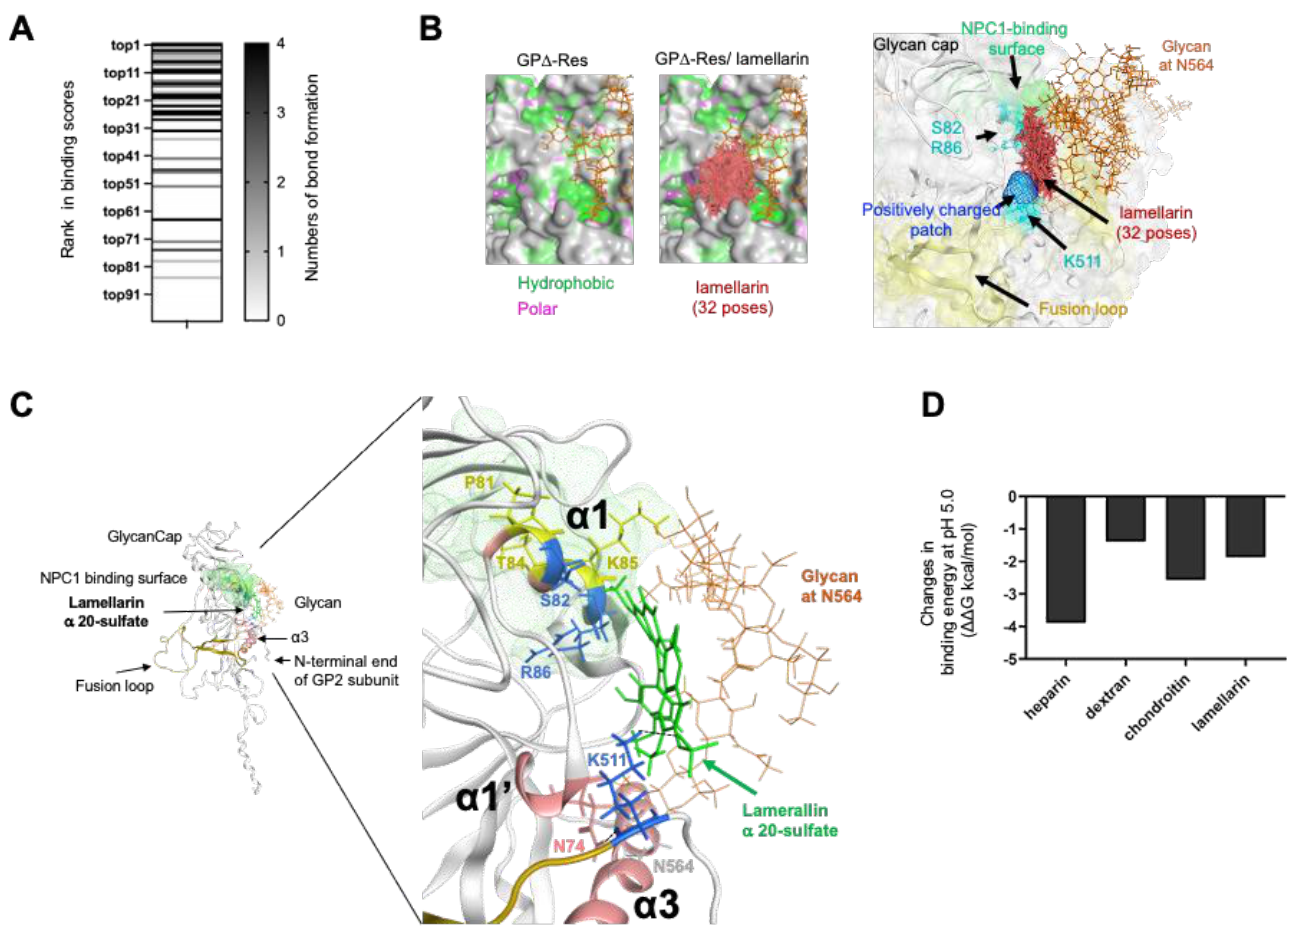
Figure 9. Characterization of molecular interactions between lamellarin α 20-sulfate and the Ebola virus glycoprotein at the major binding sites. ( A ) Ranking of the 32 docking poses in the principal binding site. Individual docking poses of lamellarin α 20-sulfate in the site depicted by the red arrow in Figure 7D are illustrated with horizontal lines along with information about the ranking of the docking scores (letters at left) and the number of noncovalent bonds (dark band at right). ( B ) Superposition of the 32 docking poses of lamellarin α 20-sulfate in the principal binding site. Red rod-like chains indicate lamellarin α 20-sulfate atoms. ( C ) Binding mode with the highest (number 1) docking score. Blue residues in the α1 helix of the GP1 subunit (S82 and R86) and at the base of the fusion loop of the GP2 subunit (K511) indicate those involved in noncovalent interactions with lamellarin α 20-sulfate. Yellow residues in the α 1 helix (P81, T84, and K85) are the residues supporting NPC1 binding in the Zaire Ebola virus [91]. The dotted line indicates a hydrogen bond between the main chain of K511 and the side chain of N74. ( D ) Augmentation of the binding affinity of sulfated compounds under acidic conditions. Docking poses with the highest (number 1) scores were used to calculate the binding free energies of sulfated compounds on Ebola virus GPΔ -Res at pH 7.0 and pH 5.0 using the Protonate 3D tool [64] in MOE. Changes in the binding free energies at pH 5.0 are shown.